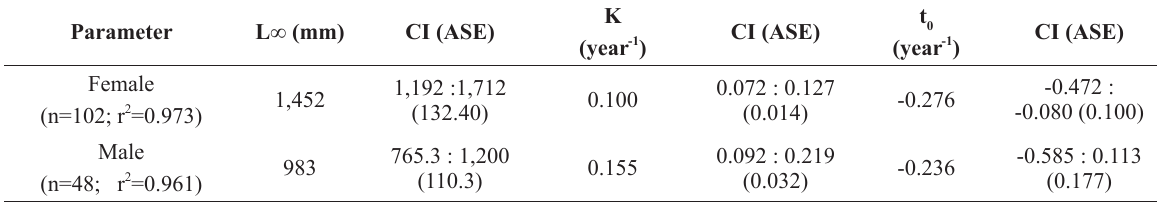
Back calculation growth (BPH) parameters fitted to von Bertalanffy function for the pink cusk-eel Genypterus brasiliensis (CI: 95% confidence interval, ASE: asymptotic standard